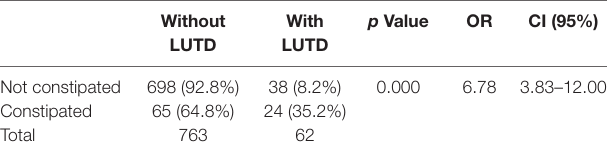
TaBle 1 | relationship between constipation and the presence of lUTD.